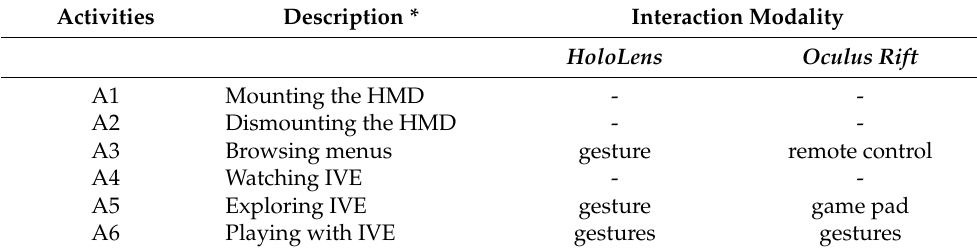
Table 4. Performed activities and associated interaction modality. One may notice that the only interaction modality with the environment experienced via the HoloLens was by gestures , while in the case of the Oculus Rift session, available interaction modalities include also remote control and game pad . Activities Description * Interaction Modality HoloLens Oculus Rift A1 Mounting the HMD - - A2 Dismounting the HMD - - A3 Browsing menus gesture remote control A4 Watching IVE - - A5 Exploring IVE gesture game pad A6 Playing with IVE gestures